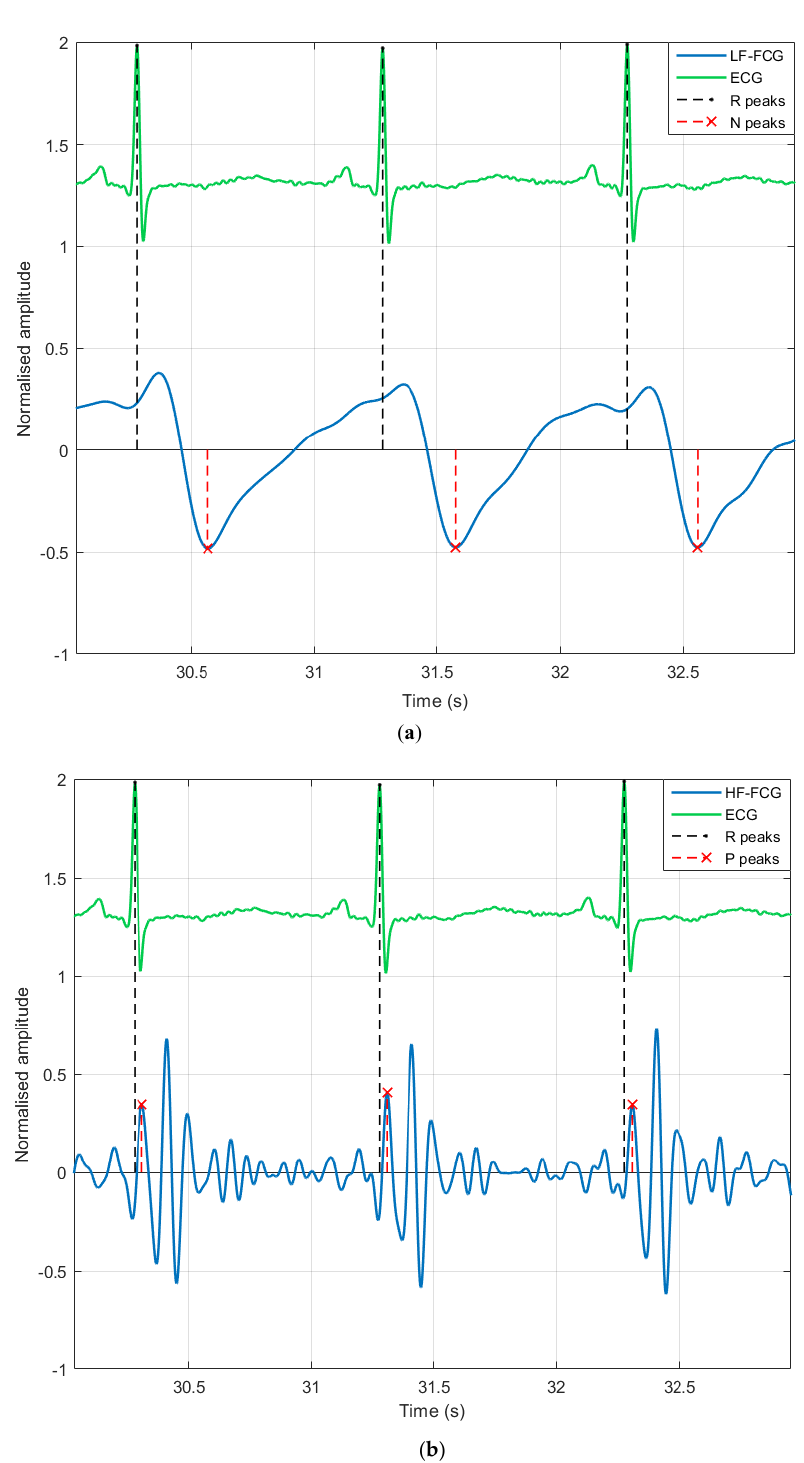
Figure 7. Subject #5 dataset. ( a ) Excerpt of ECG and LF-FCG signals (3 consecutive heartbeats) showing fiducial points located on LF-FCG; ( b ) excerpt of ECG and HF-FCG signals (same 3 consecutive heartbeats) showing fiducial points located on